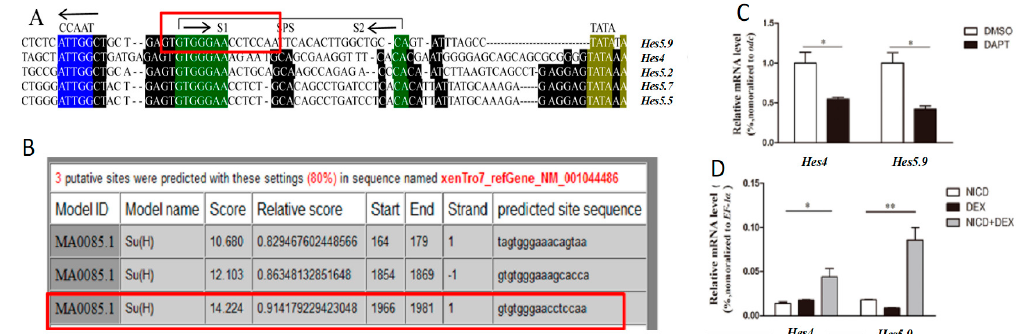
Figure 2. The Hes5.9 is regulated by the Notch signaling. ( A ) Promoters of Hes5.9 , Hes4, Hes5.2, Hes5.7, and Hes5.5 show high and moderate homology of S1 and S2, respectively, in the SPS (green). All exhibit a conserved CCAAT motif (blue) and TATA box (yellow). ( B ) The predicted Notch binding sequences of Hes5.9 . The expression patterns of Hes4 and Hes5.9 are affected by inhibition ( C ) or induction ( D ) of the Notch signaling, * p < 0.05; ** p < 0.01.